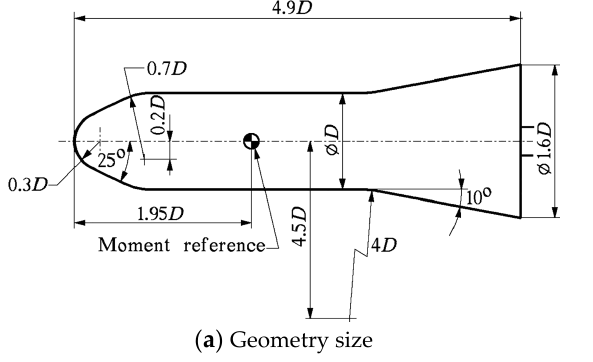
Figure 2. Geometry size and grid of HB ‐ 2 test